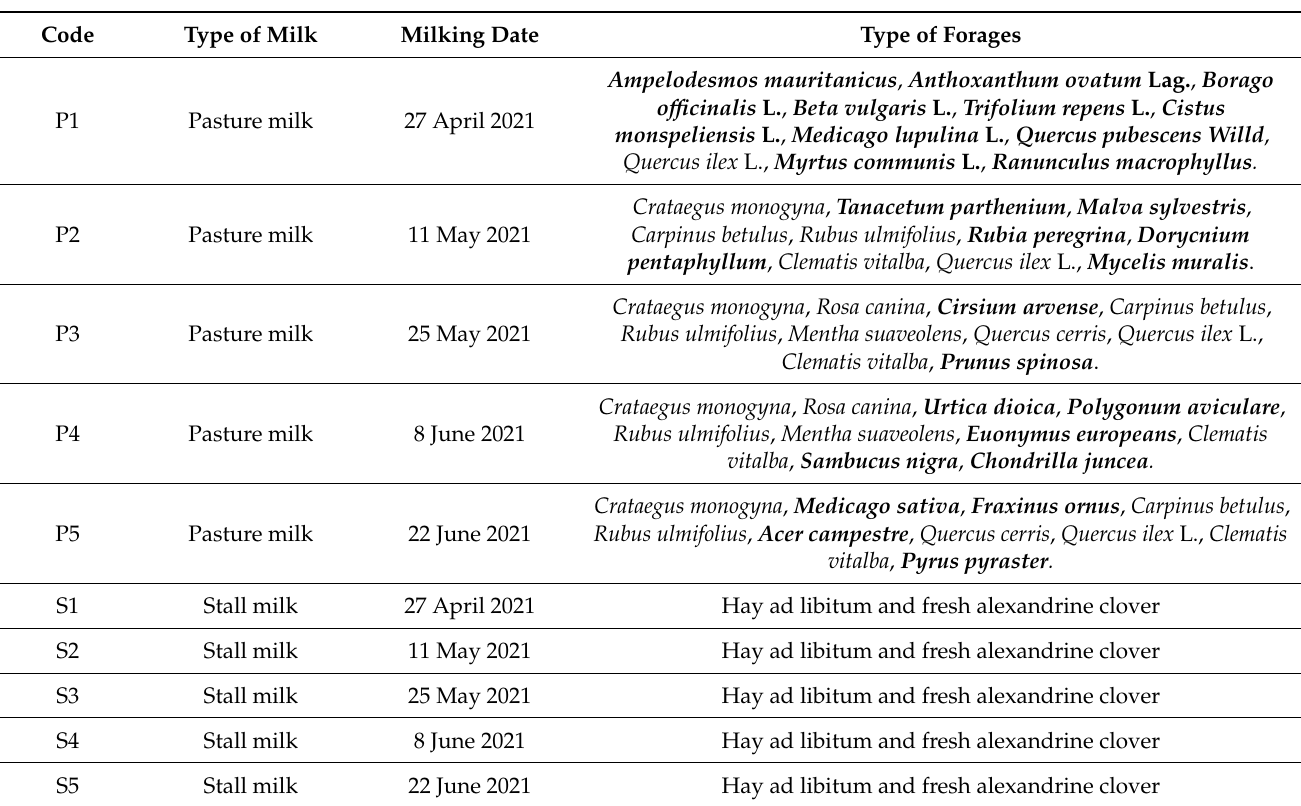
Table 1. Milk samples measured by electronic nose, evaluated by sensory panel and analysed by